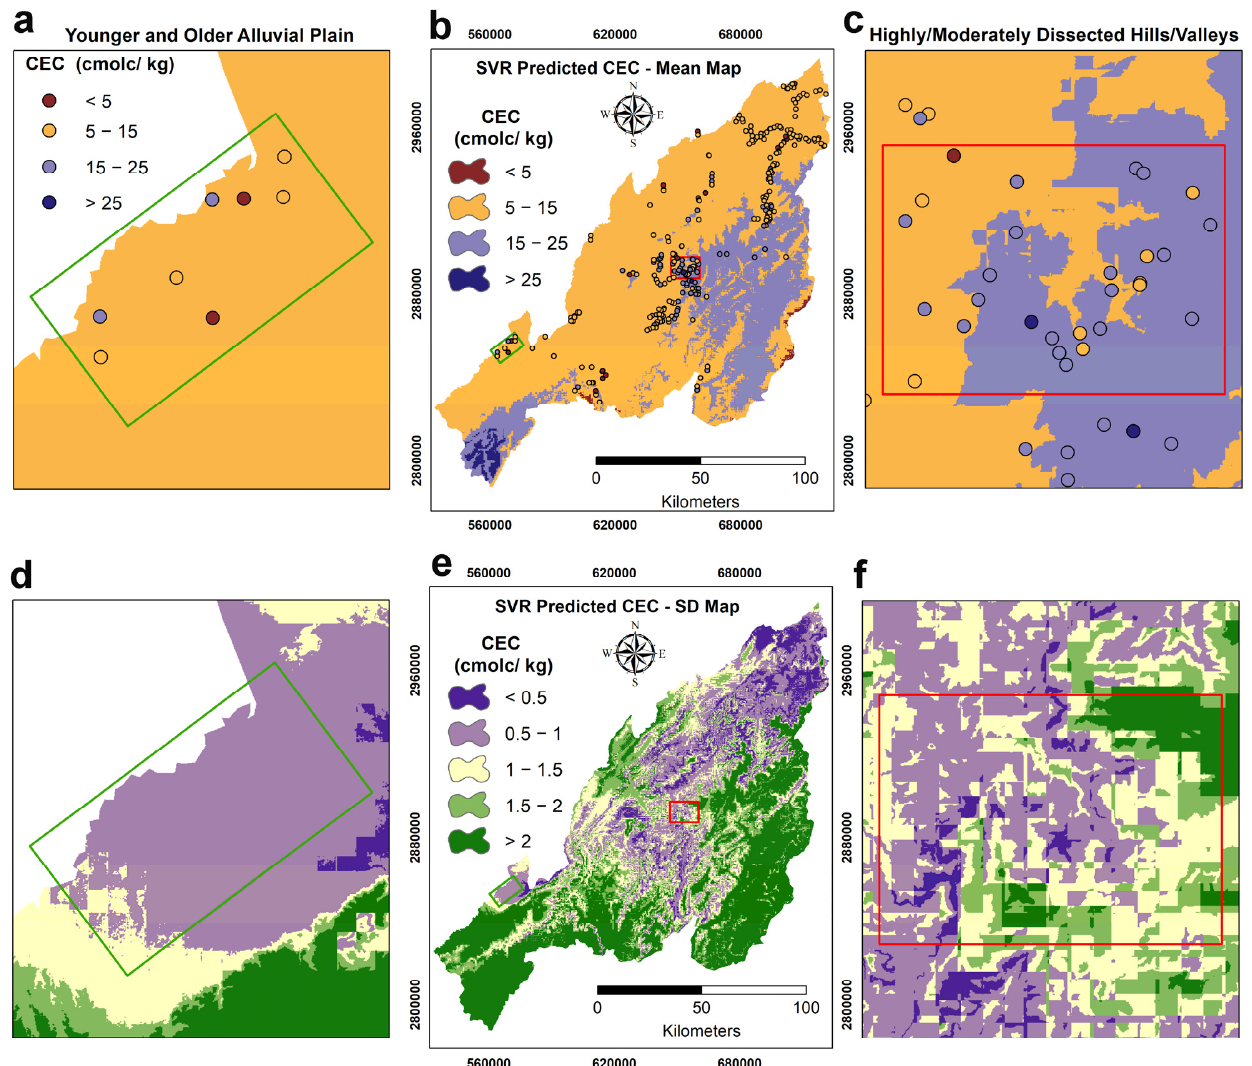
Figure 6. Digital maps of CEC (0–30 cm) were generated by applying a Support Vector Regression (SVR) model: Zoomed to a young and older alluvial plain area as mean CEC map ( a ) and as uncertainty CEC map ( d ); mean CEC map over Nagaland ( b ) resulting from the prediction among 10 iterations; zoomed to a highly/moderately dissected hills and valleys as mean CEC map ( c ) and as uncertainty CEC map ( f ); uncertainty CEC map over Nagaland ( e ) resulting from the standard deviation of 10 iterations.